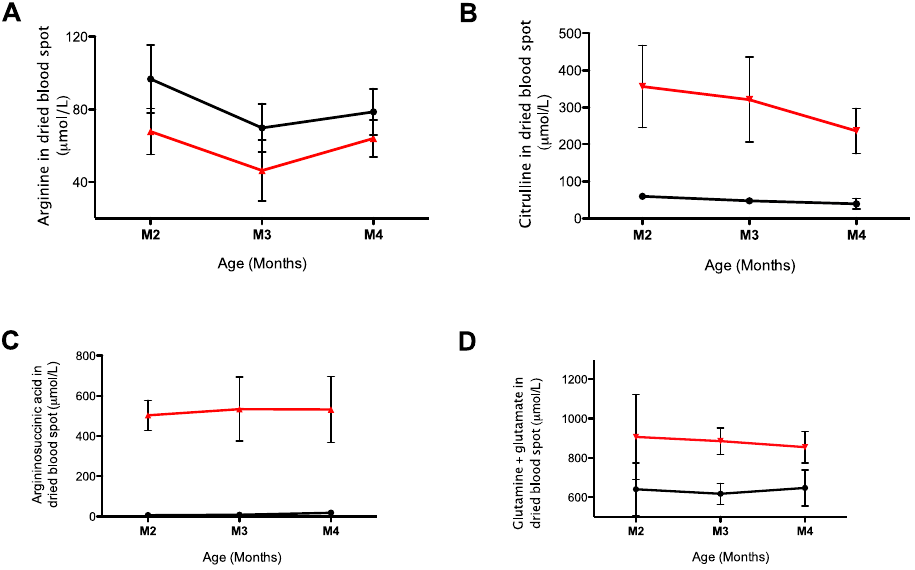
Figure 2. Monitoring of urea cycle-related amino acids overtime in Asl Neo / Neo mice. ( A ) Arginine, ( B ) citrulline, ( C ) argininosuccinic acid and anhydrides, and ( D ) glutamine and glutamate in WT ( n = 8–18), and Asl Neo / Neo ( n = 5–10) littermates. Graphs represent mean ± SD.